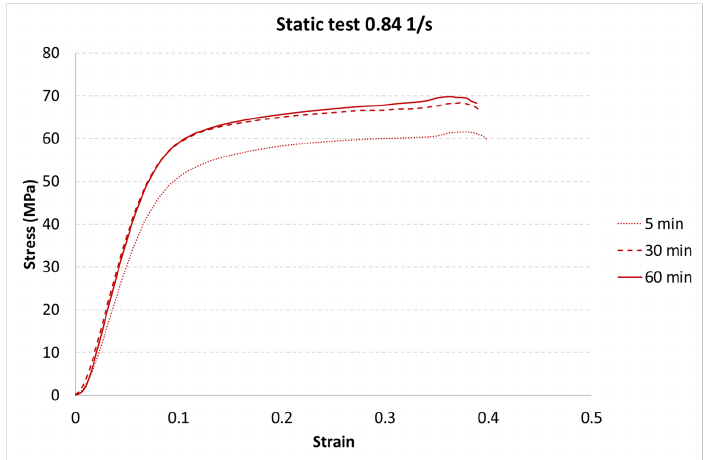
Figure 10. Results of the static test (strain rate of 0.84 1/s) of durable resin for curing times of 5, 30, and 60 min for UV and heat exposure. Materials 2020 , 13 , x FOR PEER REVIEW